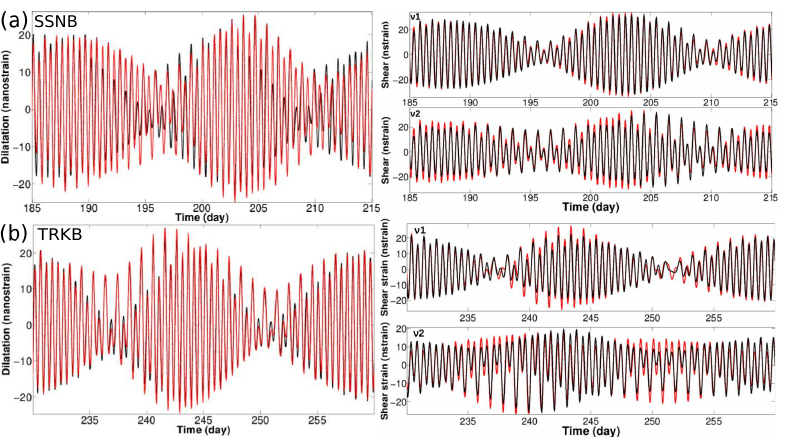
Figure 6. Calibration of dilatation (left) and shear signals ( γ 1 , γ 2 ) (right) for 3-component stations SSNB ( a ) and TRKB ( b ). Black curve denotes theoretical Earth and ocean tides and red curve denotes modeled tides, respectively, over a one-month period. Reprinted from [29] with permission from Springer